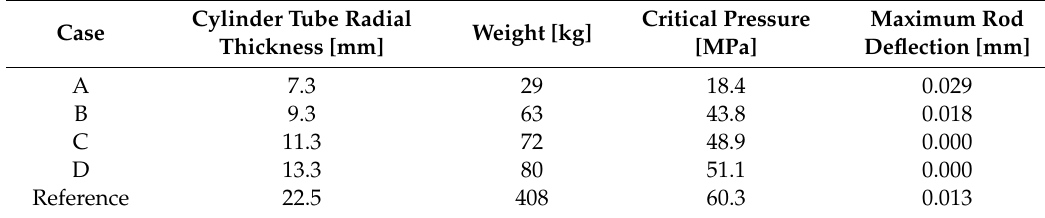
Table 8. The result of buckling